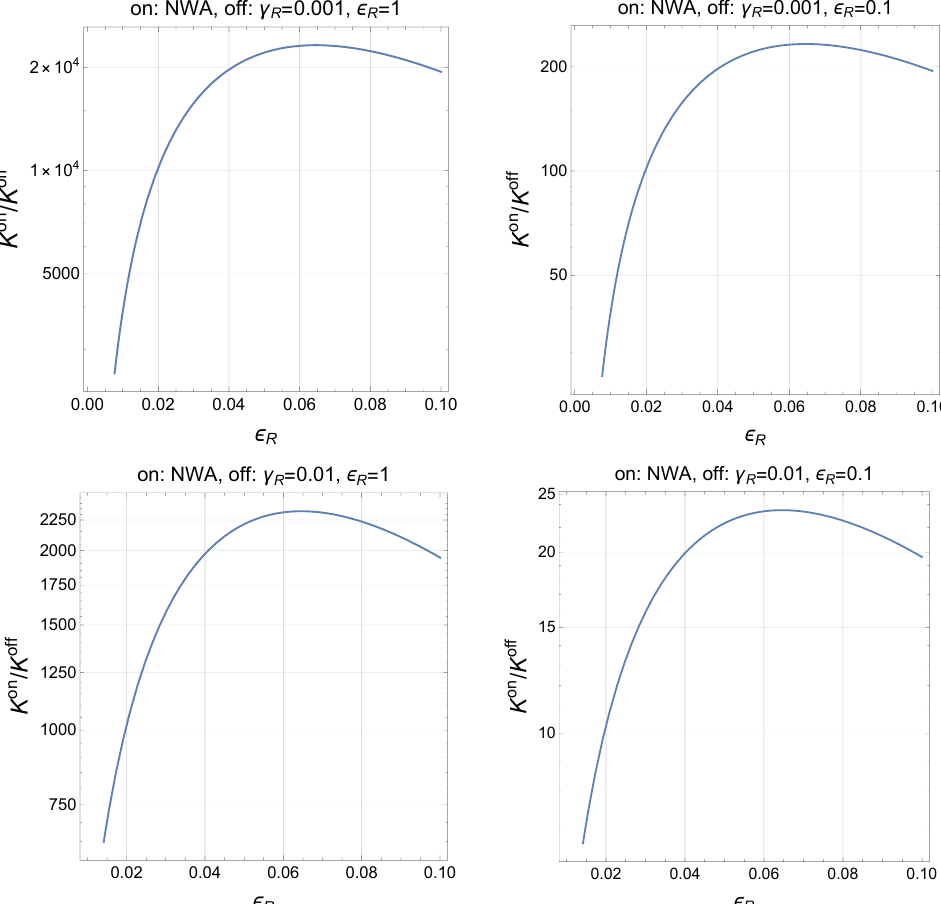
Figure 4 . K -factors on vs o(cid:11)-resonance for SIMP. Narrow Width Approximation(NWA) for the resonance is assumed and (cid:13) R ; (cid:15) R are related to the resonance width and the amount of o(cid:11)-resonance as de(cid:12)ned below eq.